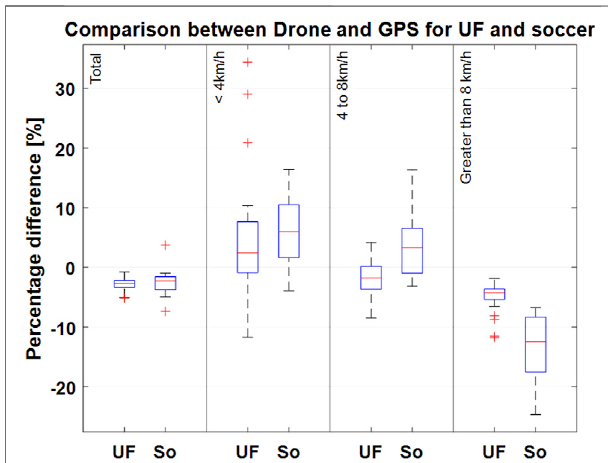
FIGURE 7 | Percentage deviation of the total distance measurements between the drone-based video system and LPS and drone-based video system and GPS in tennis for different speed zones. Boxplots show the respective median (red line); the bottom and top edges of the box indicate the 25th and 75th percentiles (blue box). The whiskers extend to the most extreme data points without considering any outliers ( “ + ” symbol).